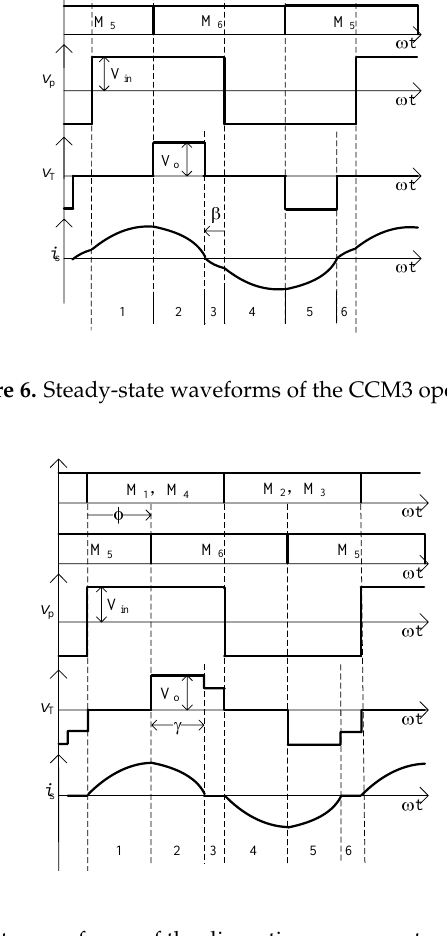
Figure 7. Steady-state waveforms of the discontinuous current mode (DCM)